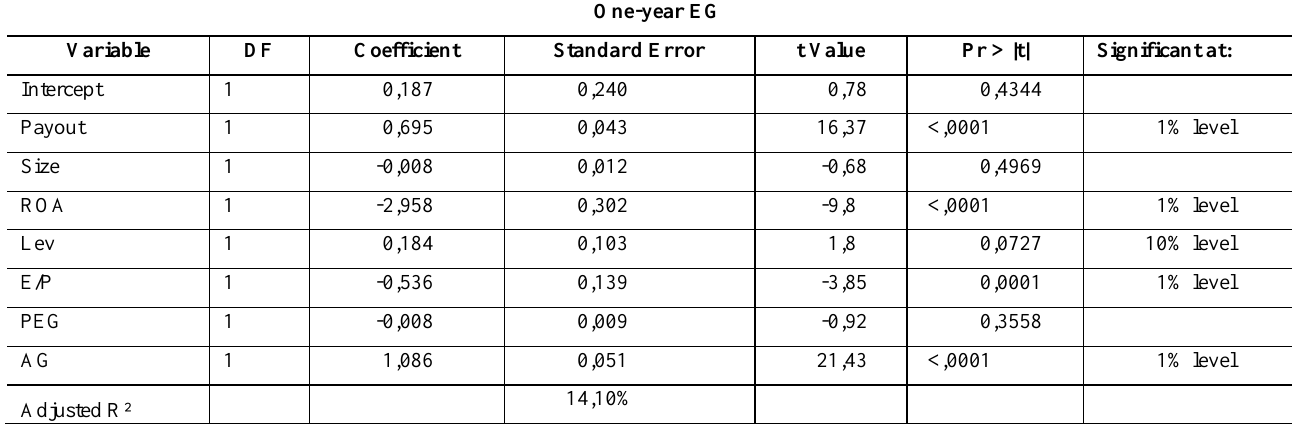
Table 7: Future earnings growth as a function of dividend payout